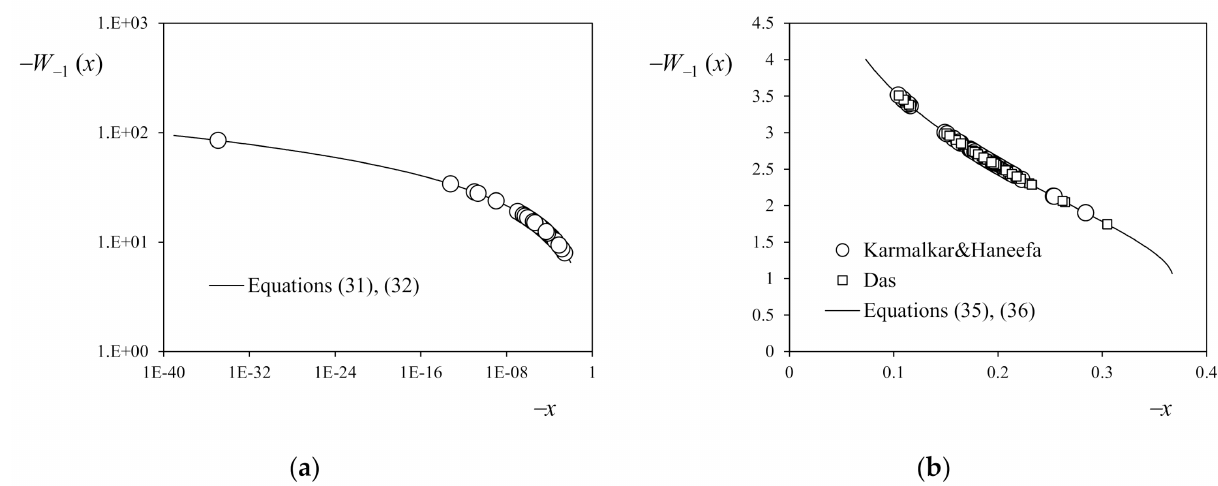
Figure 9. ( a ) Negative branch of Lambert’s W-function, W -1 , calculated for points x (Equation (30)) corresponding to the series resistance, R s , of the 1-D/2-R equivalent circuit model, based on data for solar cells/panels. Our approximate expression for W − 1 (Equations (31) and (32)) is also shown. ( b ) Negative branch of Lambert’s W-function, W − 1 , calculated for points x (Equation (33)) corresponding to the explicit models proposed by Kalmarkar and Haneefa and Das, based on data for solar cells/panels. Our approximate expression for W − 1 (Equations (35) and (36)) is also